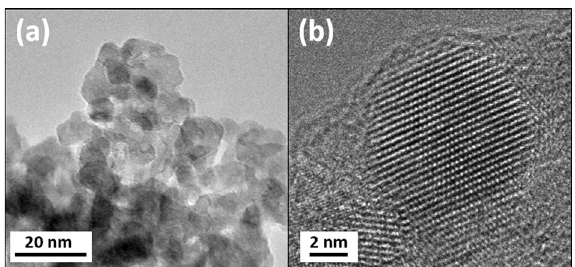
Figure 1. ( a ) Medium- and ( b ) high-resolution TEM images of the as-made Ce-doped TiO 2